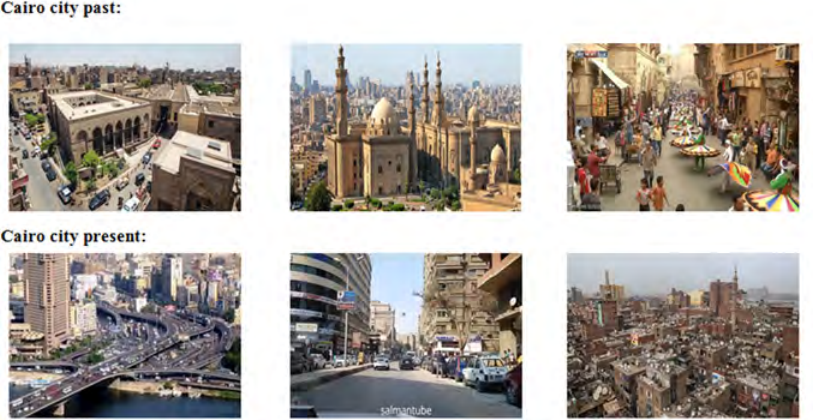
Figure 2. New Urban Identity for Cairo (past —